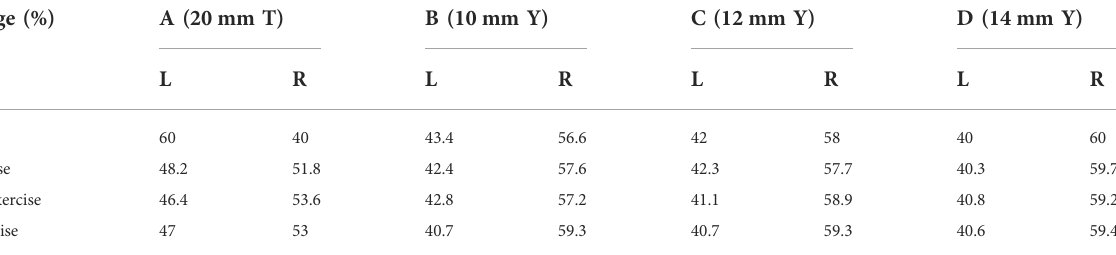
TABLE 1 Distribution of the inferior vena cava blood fl ow under different levels of exercise.